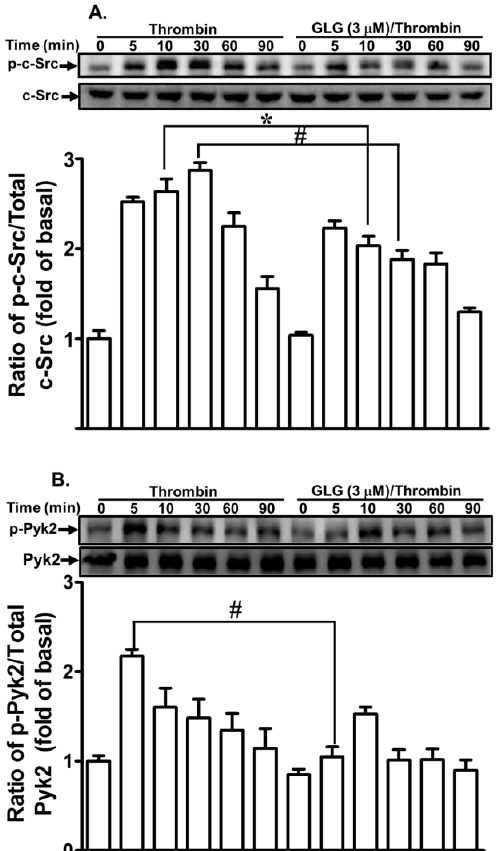
Figure 2. Galangin inhibits the thrombin-induced phosphorylation of proto-oncogene tyrosine-protein kinase (c-Src), proline-rich tyrosine kinase 2 (Pyk2). The cells were pretreated with galangin (3 µ M) for 1 h and then incubated with thrombin (10 U/mL) for the indicated time intervals. The levels of ( A ) c-Src and ( B ) Pyk2 phosphorylation and their respective protein levels were determined by western blot. The data are expressed as mean ± SEM of three independent experiments. * p < 0.05; # p < 0.01, as compared with the cells exposed to thrombin